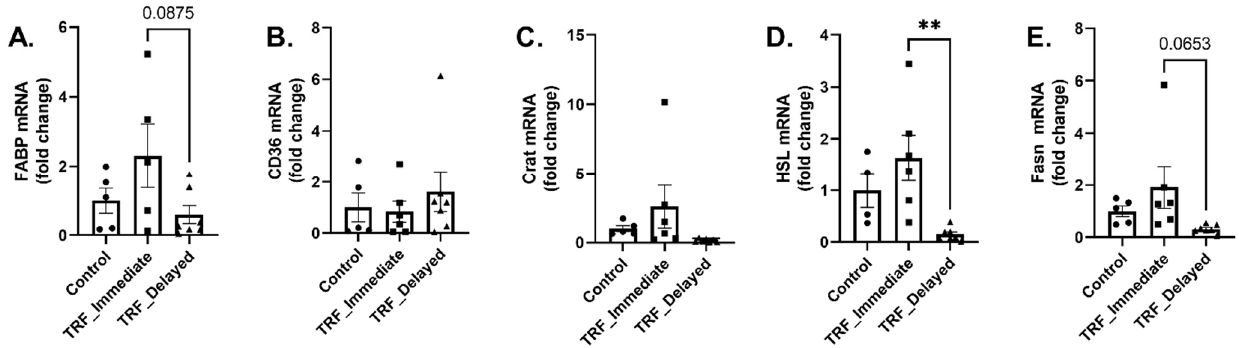
Figure 3. Transcriptional regulation of markers of lipid metabolism. mRNA expression of ( A ) FABP, ( B ) CD36/FAT, ( C ) Crat, ( D ) HSL, and ( E ) Fasn was measured in the gastrocnemius muscle. Data are presented as mean ± SEM. One-way ANOVA was used to detect significance. ** indicates significance of p ≤ 0.01.